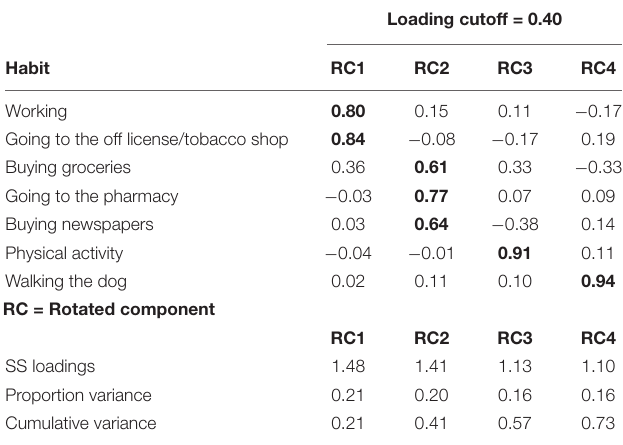
Table 5 . The only statistically significant negative